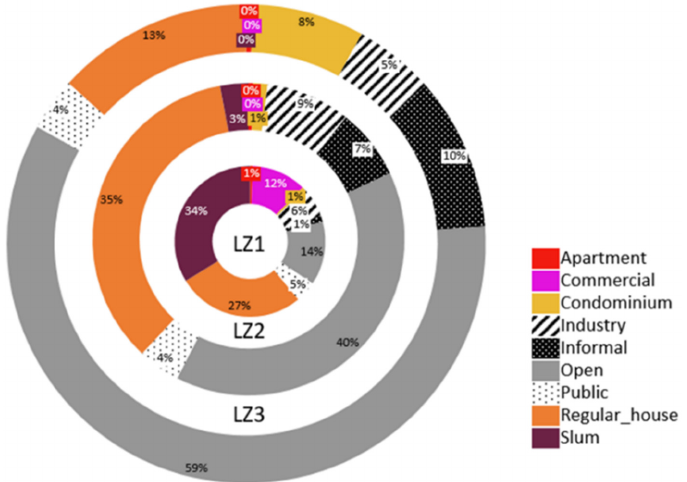
Figure 16. Addis Ababa’s land use distribution based on the three predetermined land zones. Given that the land zonation was determined based on the distance from the city center to the land price contrast, it is clear that the land use distribution is affected by this distance (Figure 17). Among the residential land uses, the slums are situated at the center of the city, while regular housing types and apartments are found in the middle, and in- formal settlements, though closer to the center than condominium housing, are set up towards the margins of the city. They are built up within available open spaces and on forest-covered hilltops, which are left open in the city’s master plan (see Figure 18). In general, condominiums are the farthest residential structures located towards the periph- ery of the city, where basic urban functions are comparably less developed [26]. Figure 17. The land use distribution plotted against the distance from the city center in kilometers.